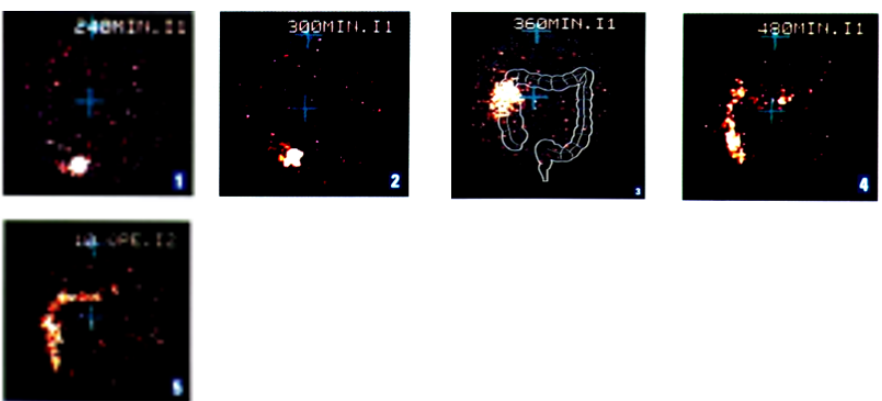
Figure 30. γ -scintigraphy of double-coated placebo Chronotopic ® systems (Methocel ® E50 applied to 100% weight gain) relevant to subject #6.